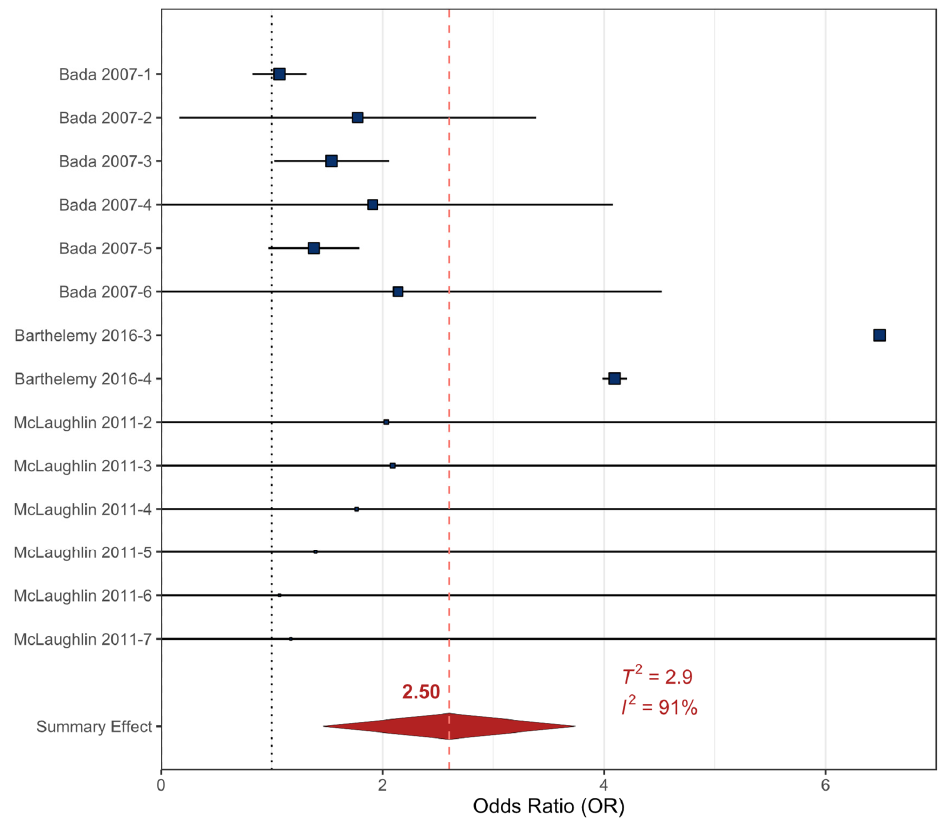
Figure 3. Forest plot showing the externalizing behavioral health outcomes included in the random effects meta-analysis for prenatal exposure to cocaine. The squares represent the mean OR from each reference dataset (Table S3), horizontal error bars represent the upper and lower 90% CI, the size variation of the boxes represents the weight each dataset had in the meta-analysis with a larger size indicating larger weights. The diamond and dashed line represent the summary effect OR based on the meta-analysis. The ‘line of no effect’ at an OR of 1 is indicated with a dotted line.